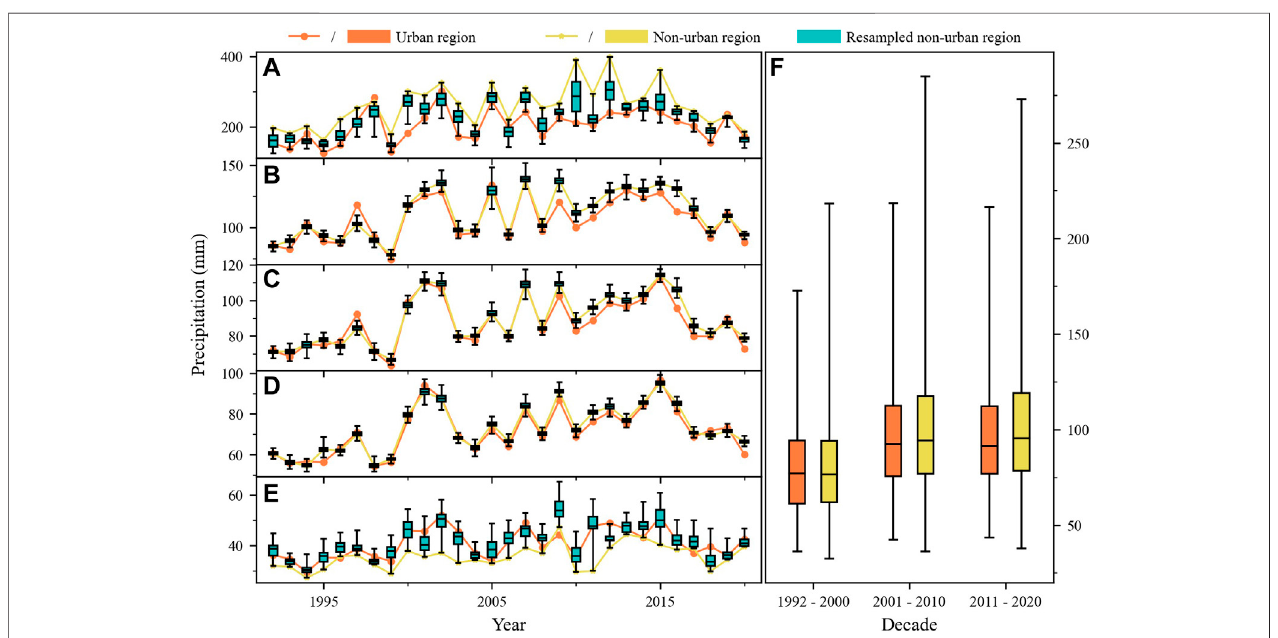
FIGURE 4 | The annual MDP in the YDM from 1992 to 2020. (A) maximum, (B) 75th percentile, (C) median, (D) 25th percentile, and (E) minimum represent the yearly changes. The boxplot of decadal averages is shown in (F) .